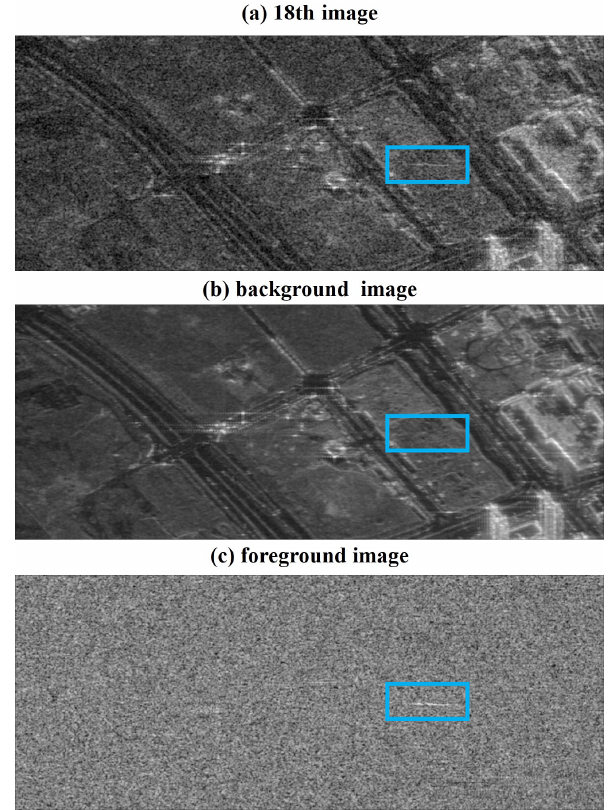
Figure 11. The processing example using 18th image of the OSLI sequence. Subfigure ( a ) is the 18th image. Subfigure ( b ) is the corresponding background image generated with OSLI (100 images). Subfigure ( c ) is the foreground image obtained by using ( a ) minus ( b ). Blue box denotes the target signature’s